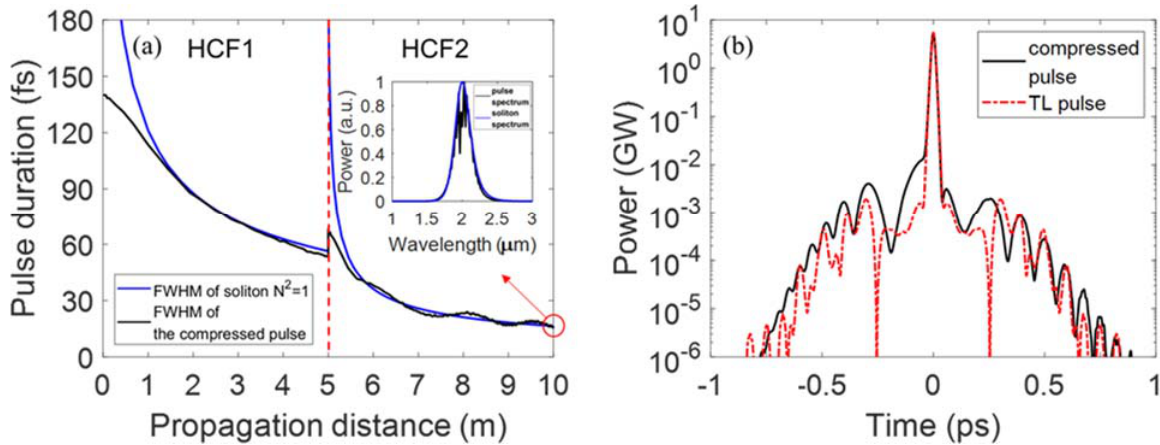
Figure 5. Two ‐ stage ASC of a positively pre ‐ chirped 125 μ J pulse at 2 μ m. ( a ) FWHM of a fundamental soliton (blue curve) and FWHM of a compressed pulse (black curve) versus the propagation distance in two ‐ stage ASC. Inset: pulse spectrum (black curve) and soliton spectrum (blue curve) at the output of the second HCF. ( b ) Compressed pulse (black curve) and transform ‐ limited (TL) pulse (red dashed curve) at HCF output.